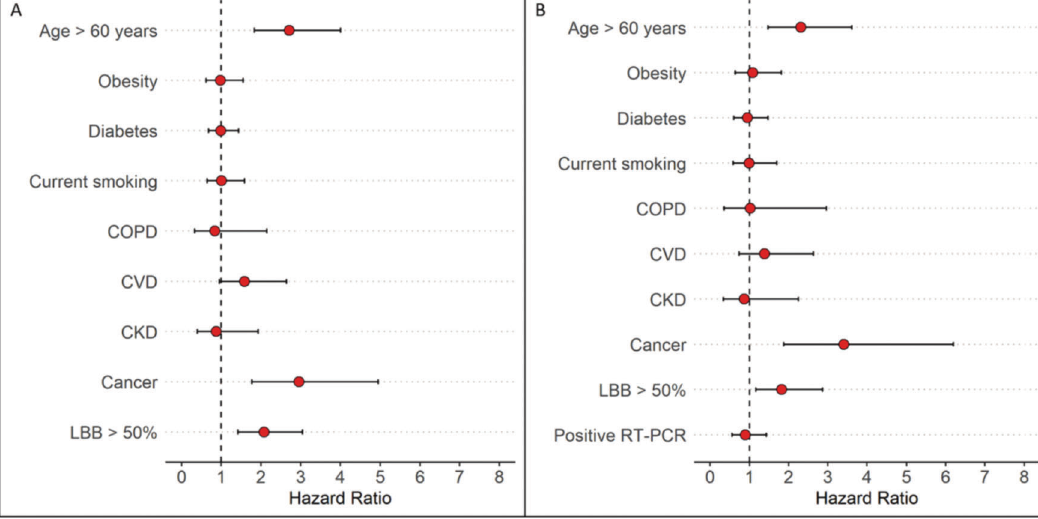
Figure 3 - Forest plot of Cox proportional hazard multivariable modeling on survival for hospitalized patients with COVID-19 after adjusting for baseline covariates and accounting for the CT findings as a time-varying covariate. A) Not including RT-PCR in the model. B) After adding RT-PCR in the model.